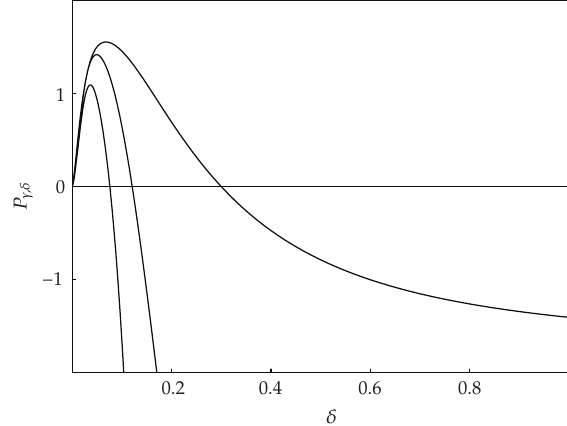
Figure 3: The limit function P γ,δ for γ (cid:9) 1 . 2 , 1 . 4 , 1 . 6 (cid:4) from right to left (cid:7) .